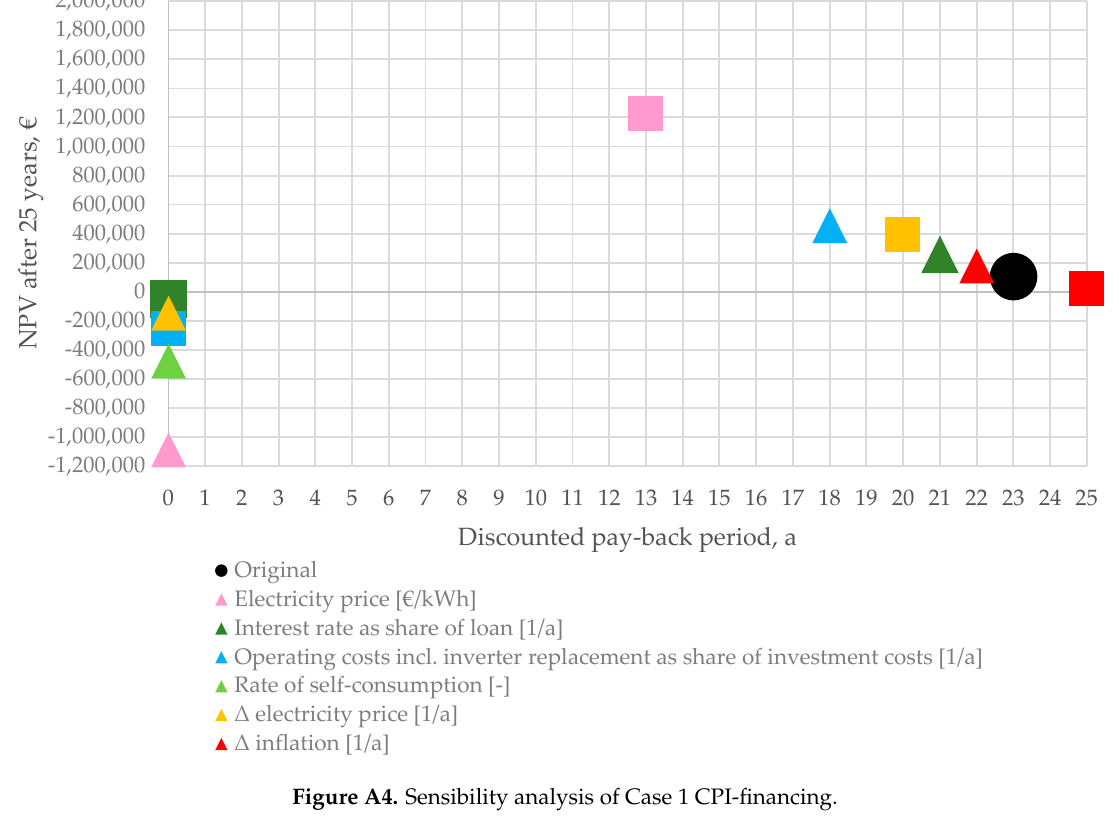
Figure A3. Sensibility analysis of Case 3 debt financing.